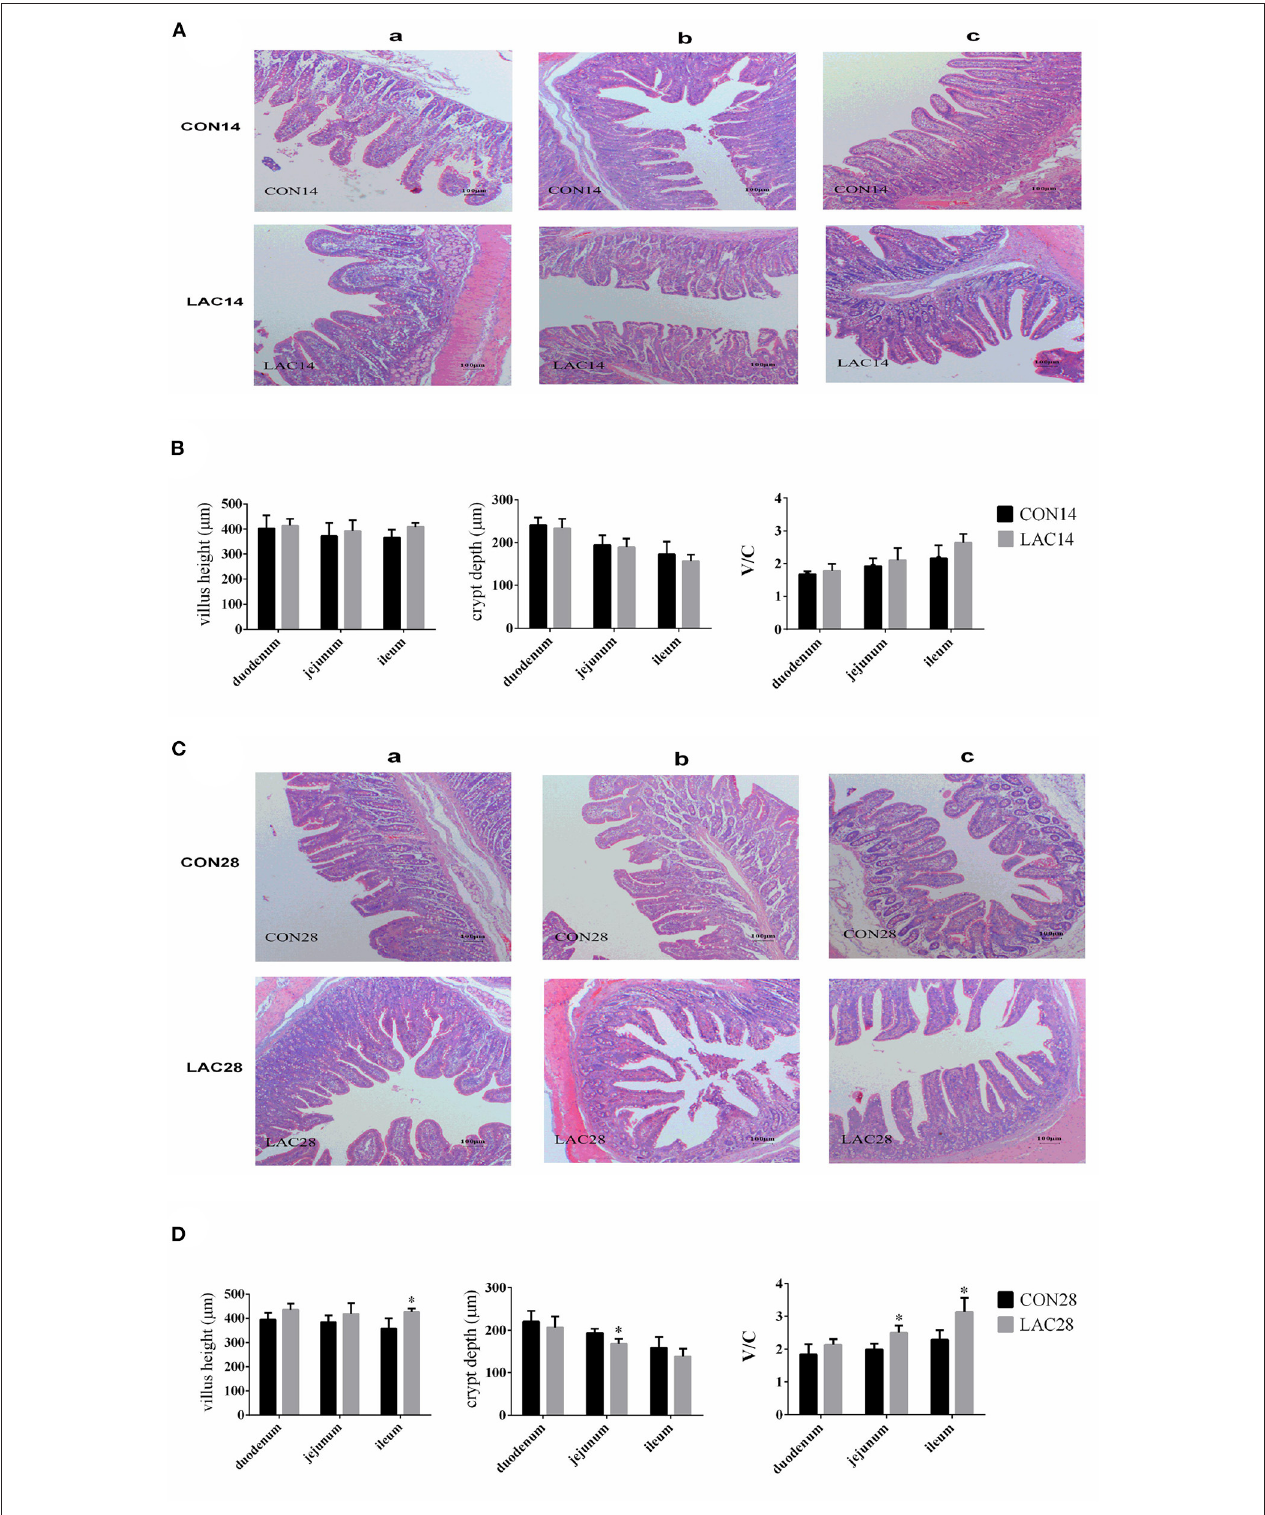
FIGURE 1 | Effects of Lactobacillus delbrueckii on the intestinal mucosal morphology of the weaned piglets. (A) Intestinal (a: duodenum; b: jejunum; c: ileum) mucosal morphology was observed (40 × ) in weaned piglets on the 14th day. (B) The villus lengths, the crypt depths, and the V/C of the intestinal sections on the 14th day. (C) Intestinal (a: duodenum; b: jejunum; c: ileum) mucosal morphology was observed (40 × ) in weaned piglets on the 28th day. (D) The villus lengths, the crypt depth, and the V/C of the intestinal sections on the 28th day. N = 4. Label (*) mean significant difference between the CON group and the LAC group ( p < 0.05). CON, basal diet; LAC, basal diet with 0.1% Lactobacillus delbrueckii